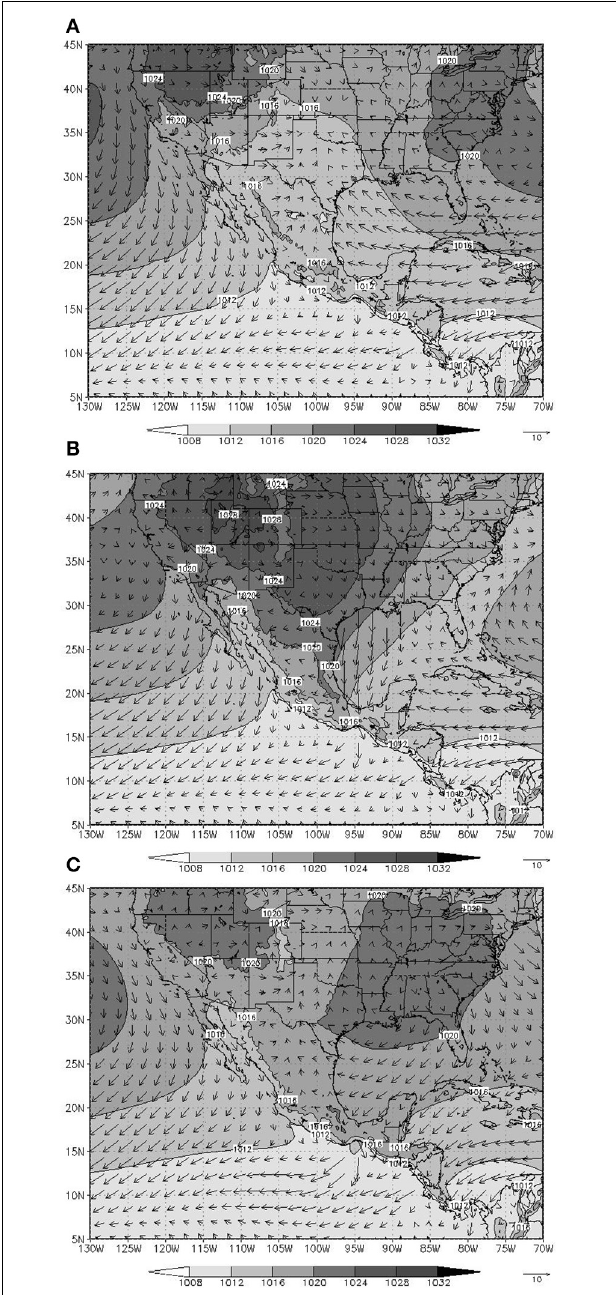
FIGURE 3 | Composite pattern of surface pressure and surface winds. (A) Two days prior to the impact of the cold surge over Veracruz, (B) during the impact, and (C) 2 days after the impact of a cold surge in Veracruz, Mexico.